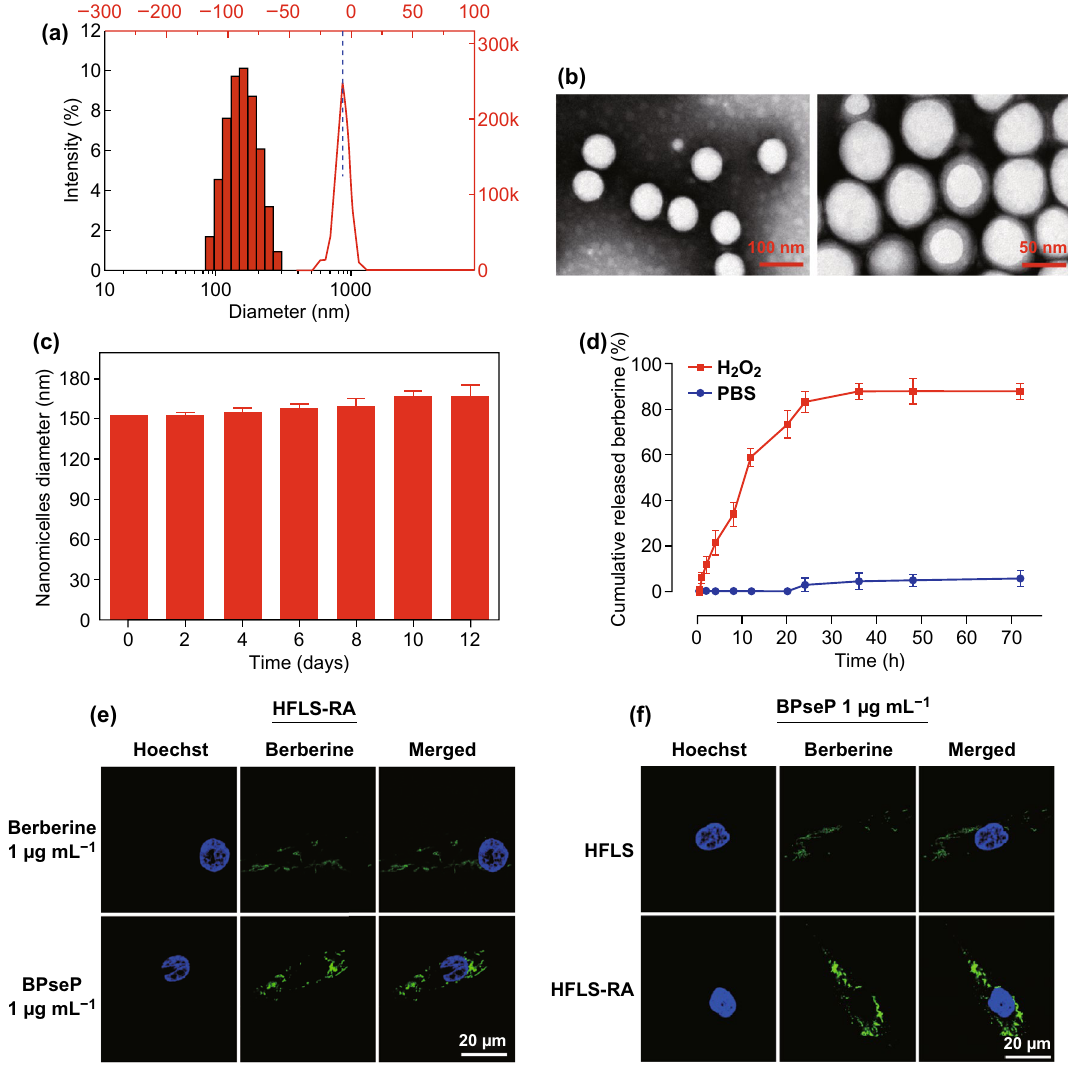
Fig. 2 a Average particle size and zeta potential of BPseP. b A uniform spherical morphology of nanoparticles. c BPseP could maintain stability at 37 °C for 2 weeks. d BPseP micelles could cumulatively release berberine quickly more than 80% because the diselenium bond in the PseP structure is sensitive to the ROS. e BPseP significantly up‑regulated the cellular accumulation of berberine. f Compared with HFLS, HFLS‑RA induced much berberine intracellular accumulation. Data were analyzed as the mean ± SEM for triplicate individual experiments (* P < 0.05, ** P < 0.01, *** P <